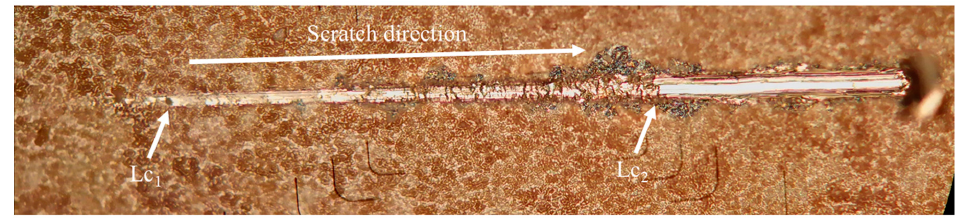
Figure 9. Scratch direction acquired by optical microscope.